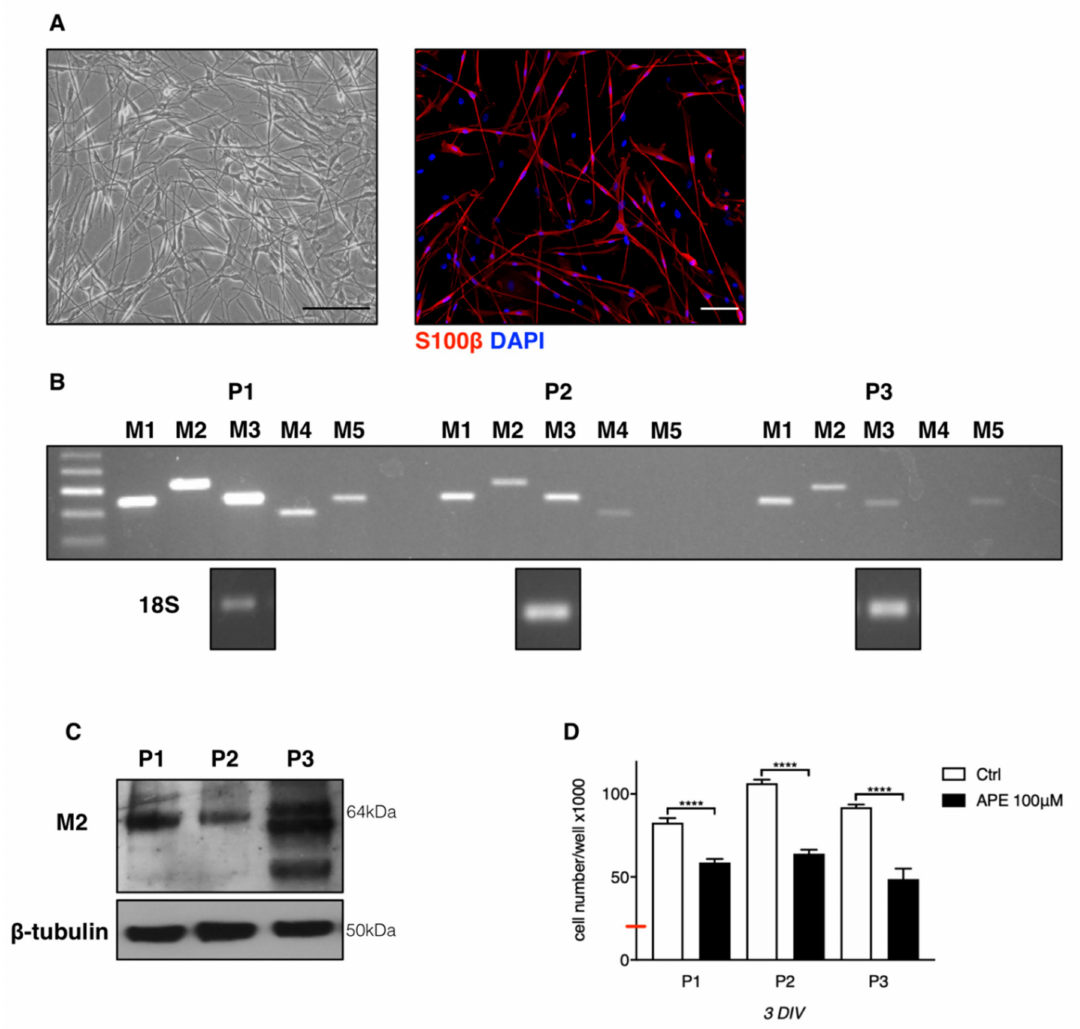
Figure 1. ( A ) Human Schwann cells (hSCs) were photographed at contrast-phase microscope (scale bar = 100 µ m); hSCs show a typical bipolar morphology. Immunostaining for S100 β appeared present in the 90% of the cultured cells (scale bar = 100 µ m). ( B ) Analysis by RT-PCR of muscarinic receptors subtypes in hSCs obtained from 3 di ff erent patients (P1, P2, and P3). Here, 18s was used as housekeeping gene. ( C ) M2 muscarinic receptor expression of the protein samples obtained from the same patients analysed by RT-PCR. β -tubulin was used as reference protein. ( D ) MTS assay showing the ability of M2 agonist APE to reduce cell growth in all three patients. The results are the average ± SEM of three independent experiments performed in triplicate (**** p < 0.0001). The red bar represents the number of cells plated (20 × 10 3 cells / well). The day after plating, cells were treated with 100 µ M APE and MTS assay was performed after 3 days of